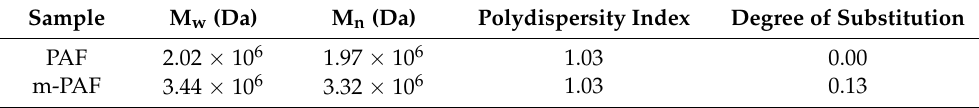
Table 1. Properties of the pineapple stem flour (PAF) and modified pineapple stem flour (m-PAF).